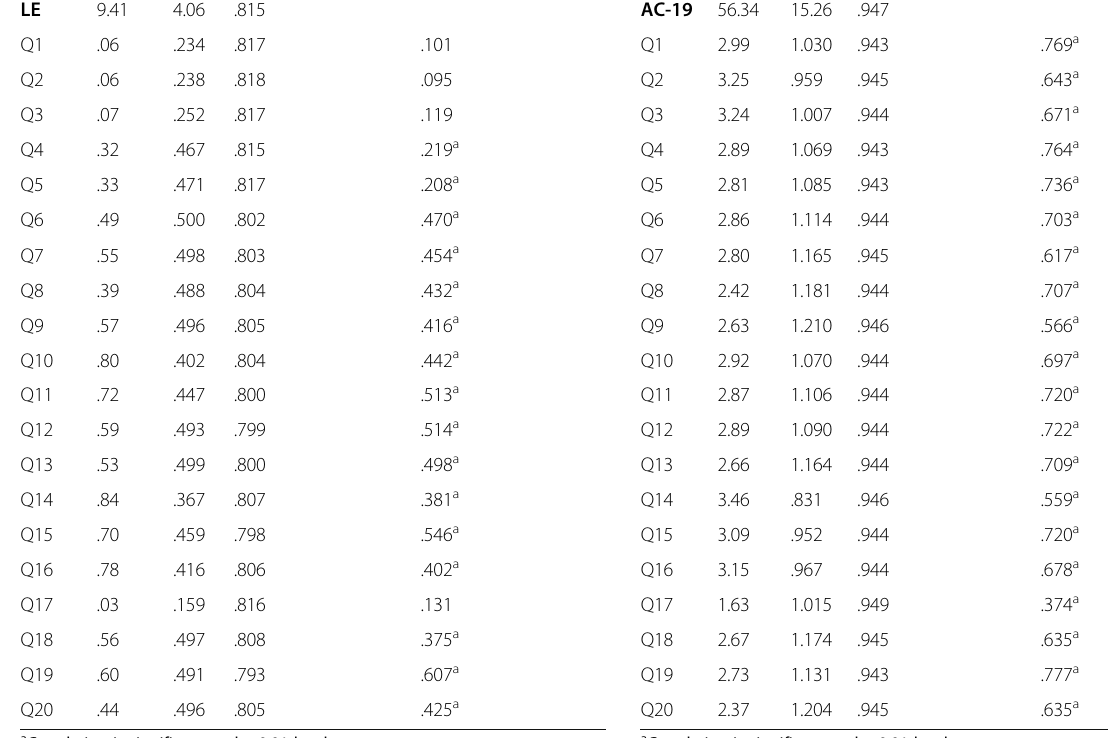
Table 5 Mean, standard deviation (SD), Cronbach ’ s alpha, and item-total correlation of each item (C-19LAI) Items